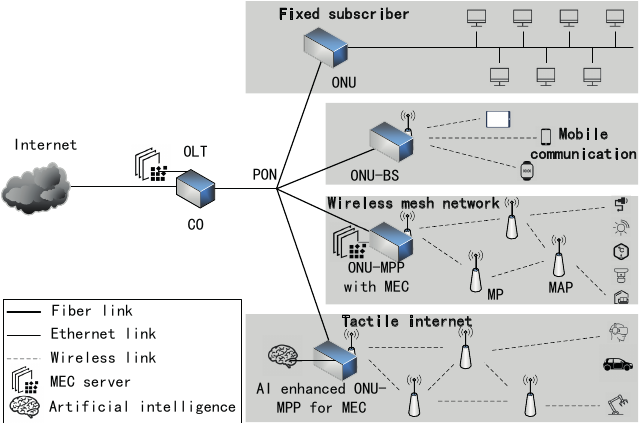
Figure 1. The FiWi